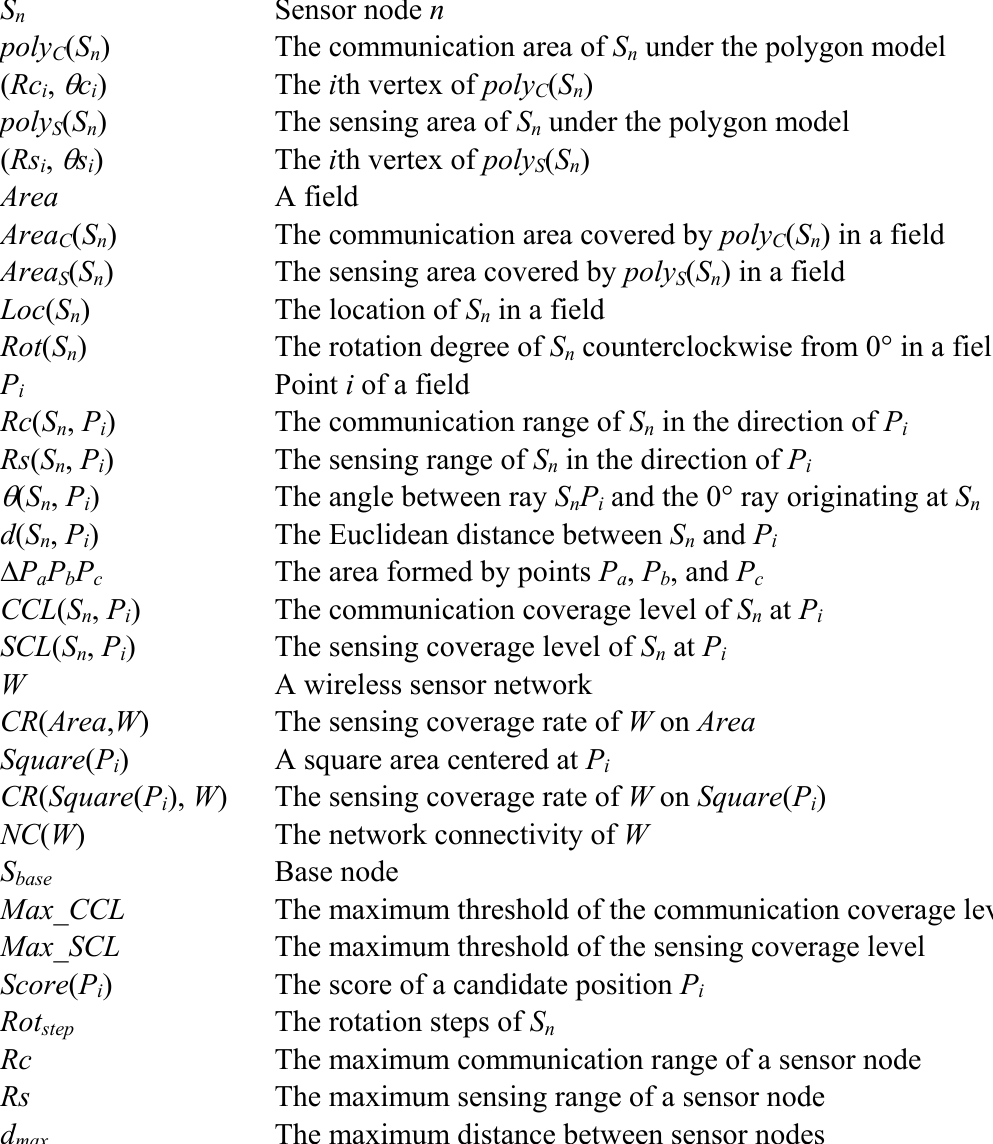
Table 1. The definitions of symbols used in this